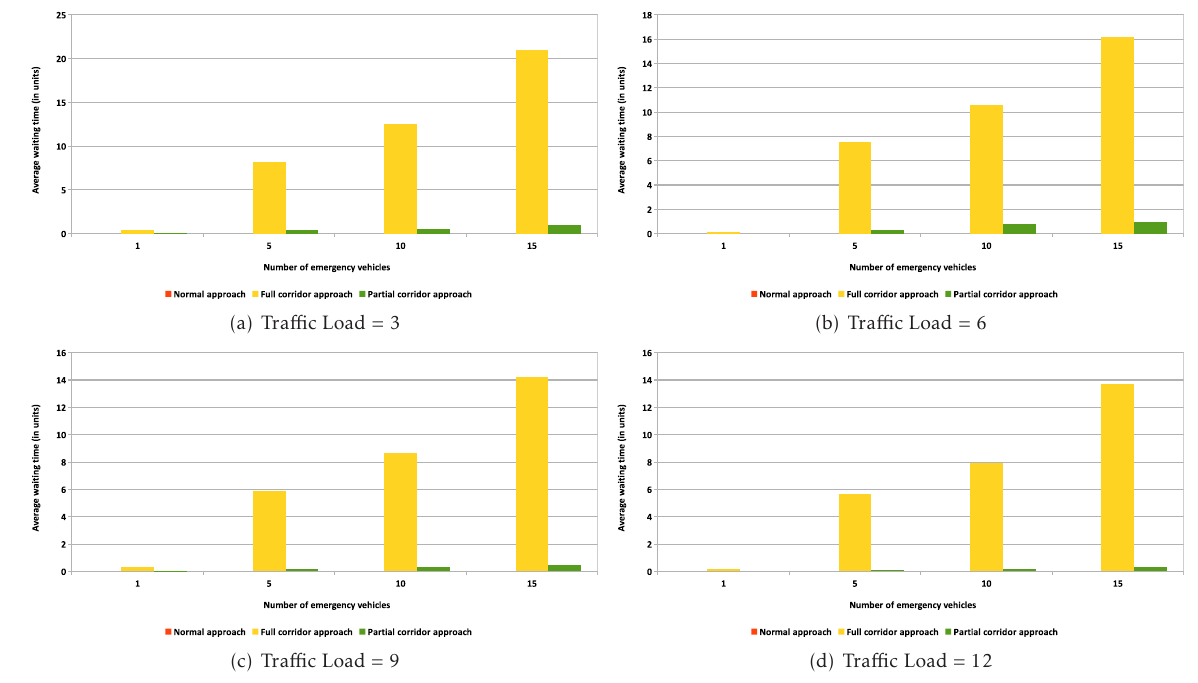
Figure 5. The average waiting time of other vehicles with varying number of emergency vehicles under different traffic loads with 50 other vehicles within the 500-node